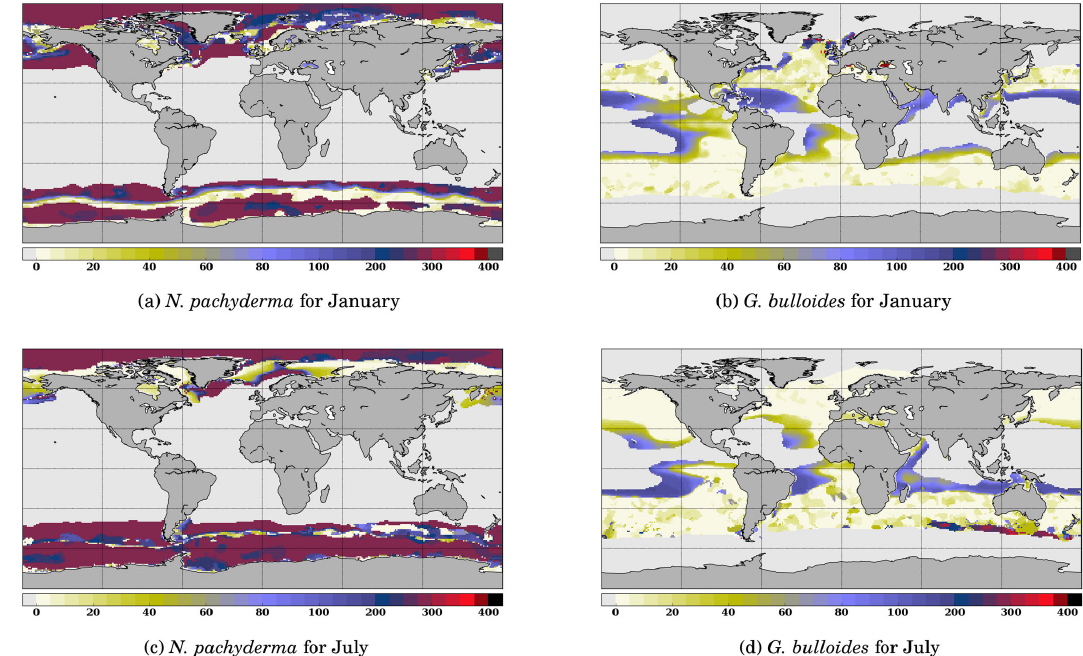
Figure 5. Comparison of the depth of maximum growth for N. pachyderma and G. bulloides for January and July. Color scale is as in Fig.